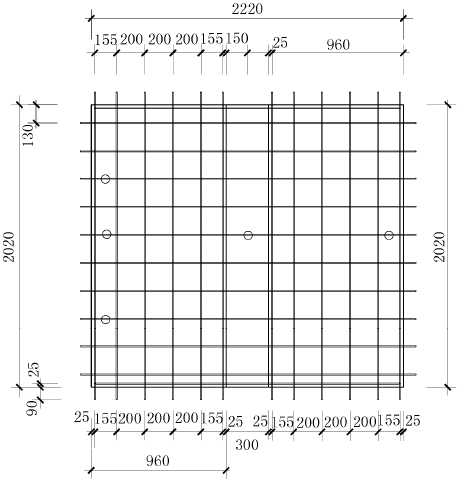
Figure 14. The lay − out diagram of concrete strain gauge lay − out on the lower surface.